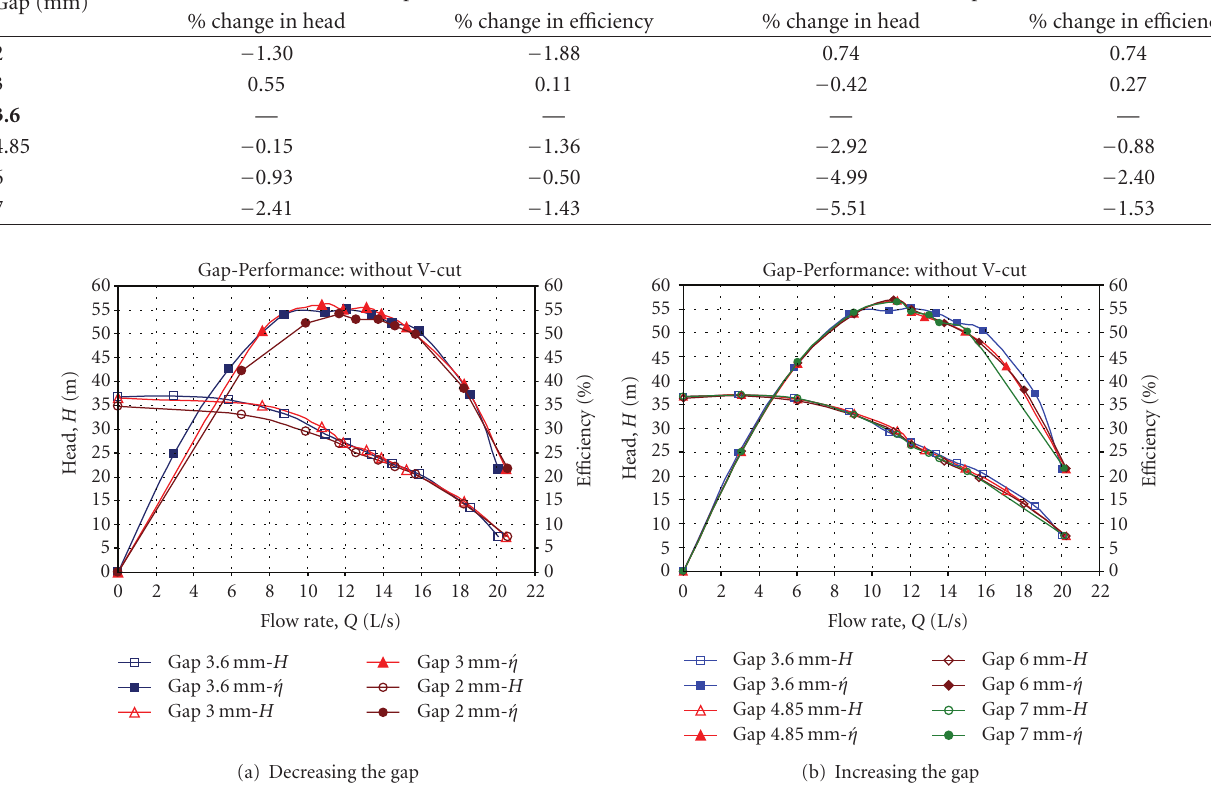
Figure 12: E ff ect of gap on pump performance: